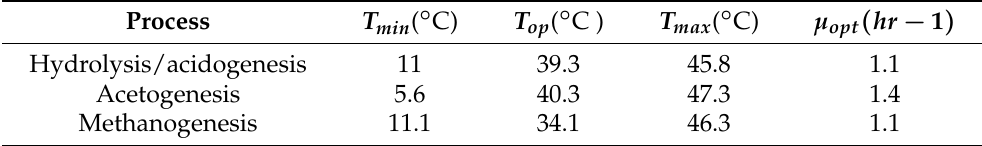
Table A1. Cardinal temperature and maximum specific growth rate at the optimal temperature for representative cells of the different phases in the anaerobic digestion